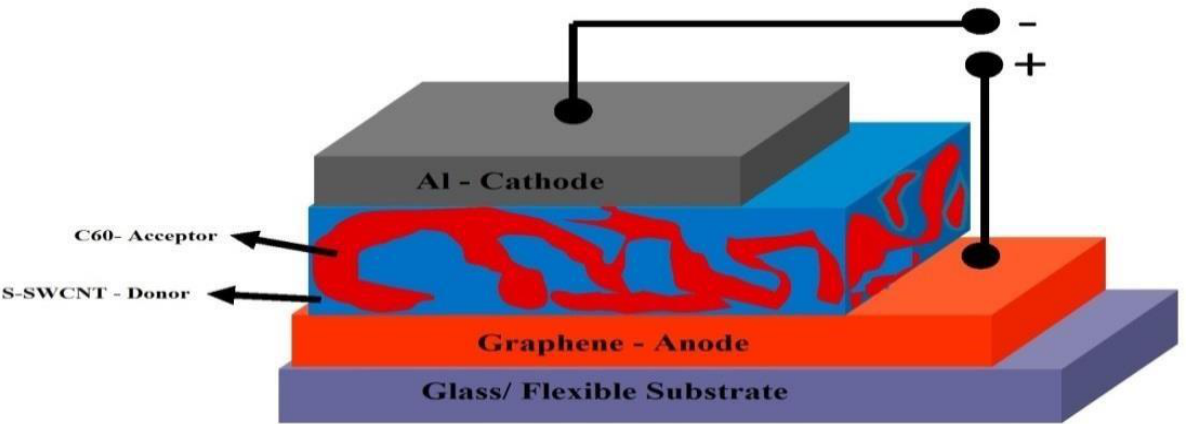
Figure 1. Structure of Bulk Hetero Junction (BHJ) Single Nano Photo Diode cell.